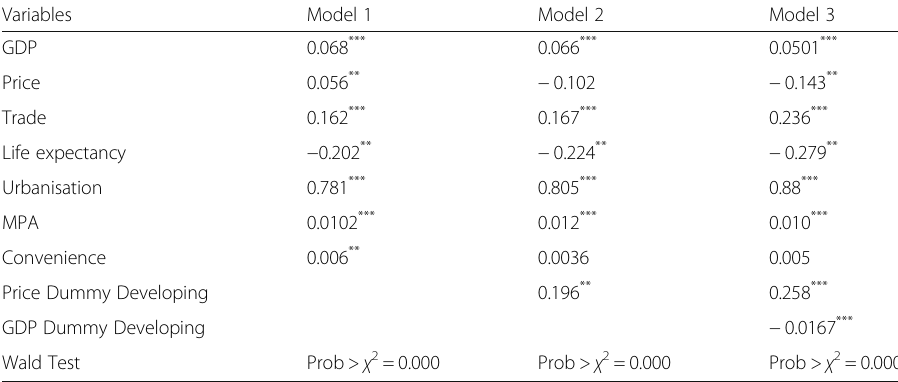
Table 2 Panel heteroskedastic with cross-sectional correlation,